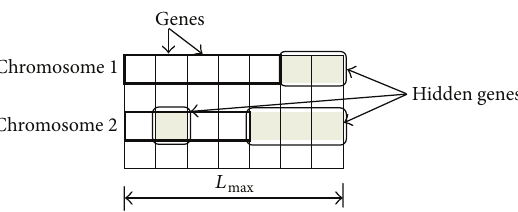
Figure 2: The addition of hidden genes makes all chromosomes become of equal